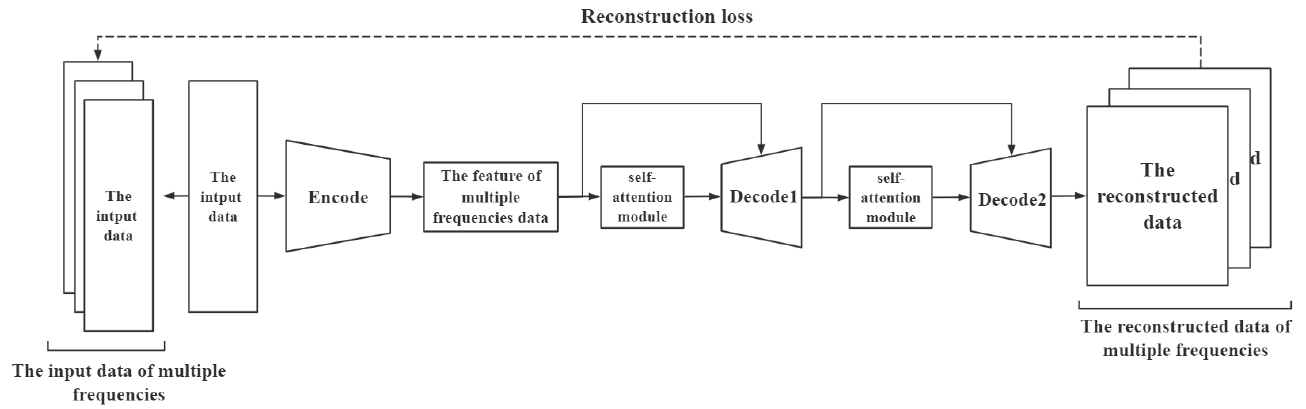
Figure 5. The overall architecture of the improved Auto-Encoder.